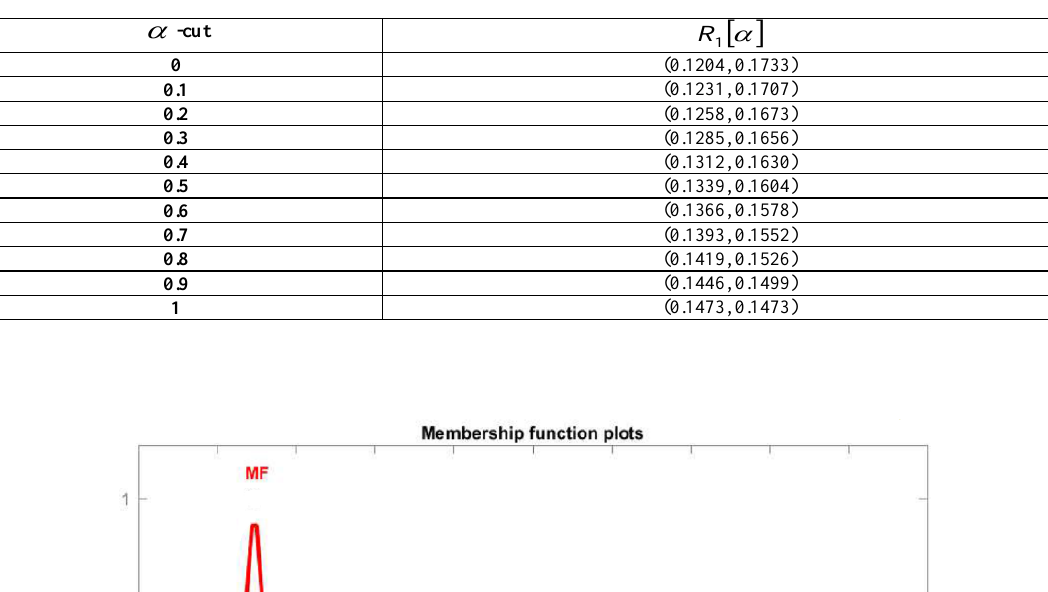
Table 4. Reliability of the circular consecutive system after aggregation operator.